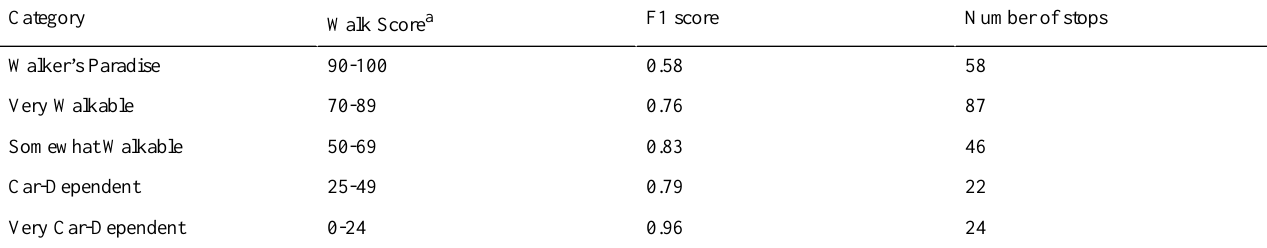
Table 7. Effects of Walk Score on performance of the activity-inference